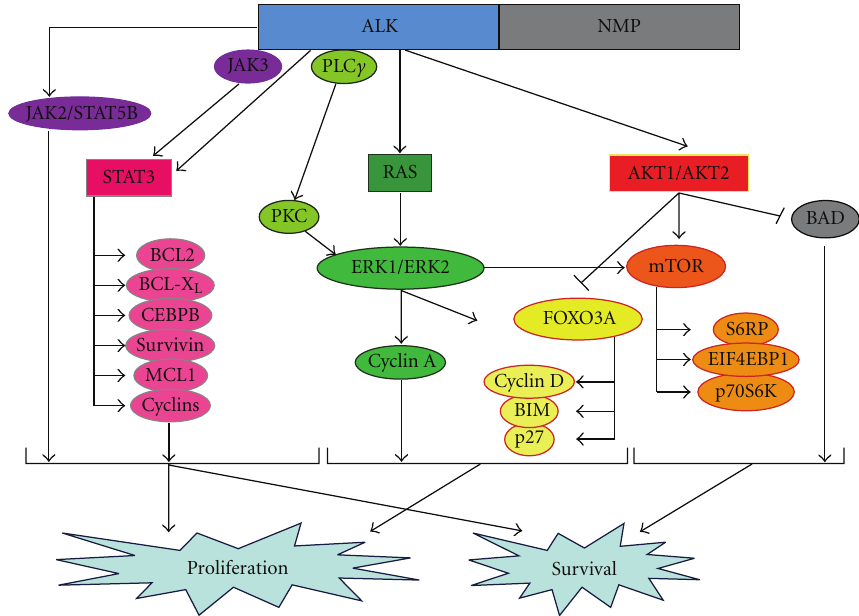
Figure 2: Schematic representation of ALK signalling. In particular, ALK signalling promotes tumor cell proliferation and survival via STAT3, RAS/ERK, and AKT/mTOR pathways. Noteworthy, the blockage of the signalling was demonstrated to have significant antitumor activity in experimental models of ALK +